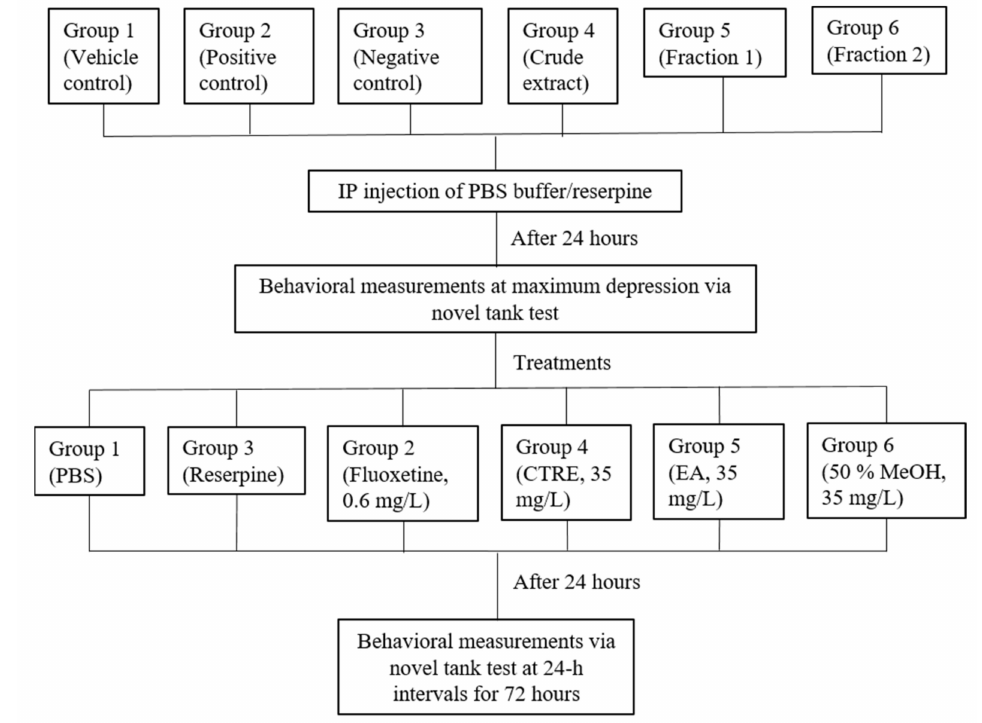
Figure 5. Groupings and experimental workflow of the zebrafish in vivo